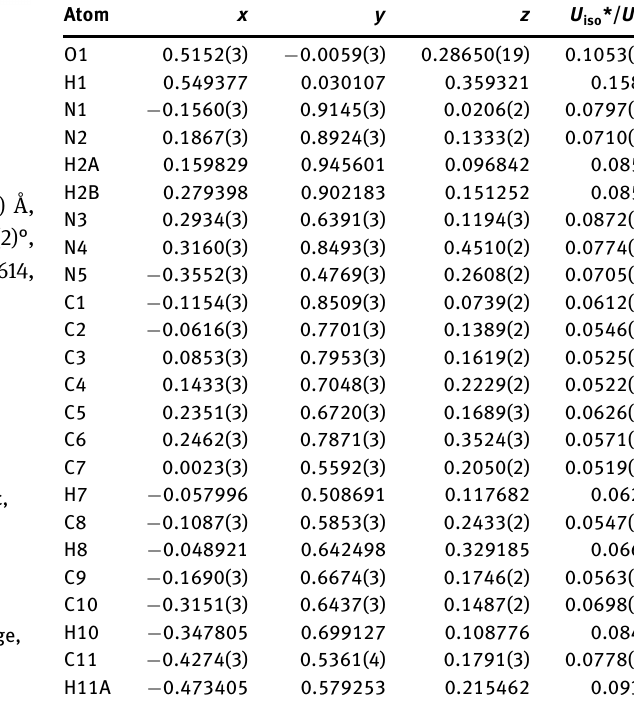
Table 2: Fractional atomic coordinates and isotropic or equivalent isotropic displacement parameters (Å 2